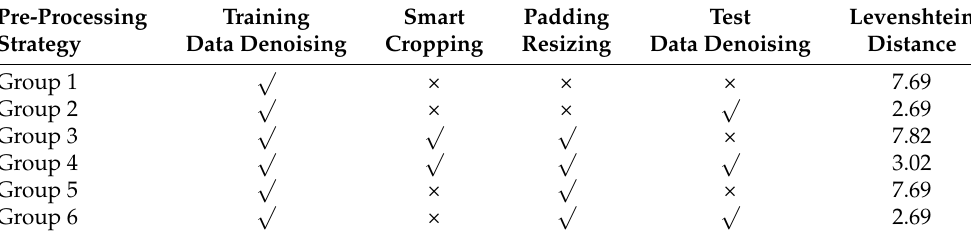
Table 4. Study of the ratio of denoised images to original training